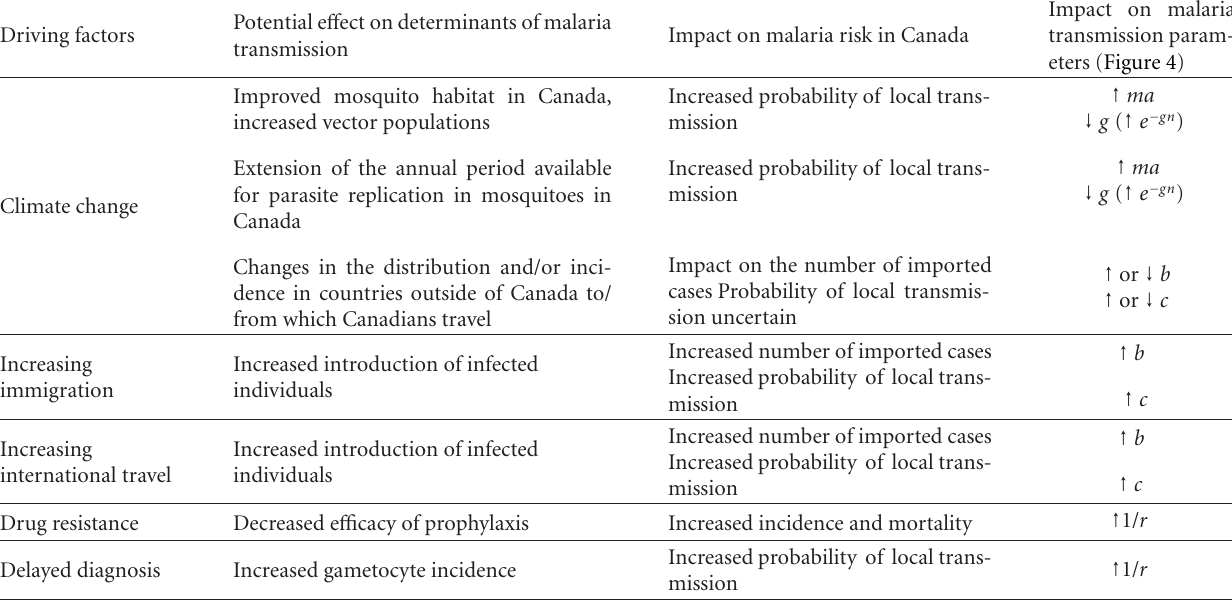
Table 3: Trends in the determinants of malaria incidence and transmission in